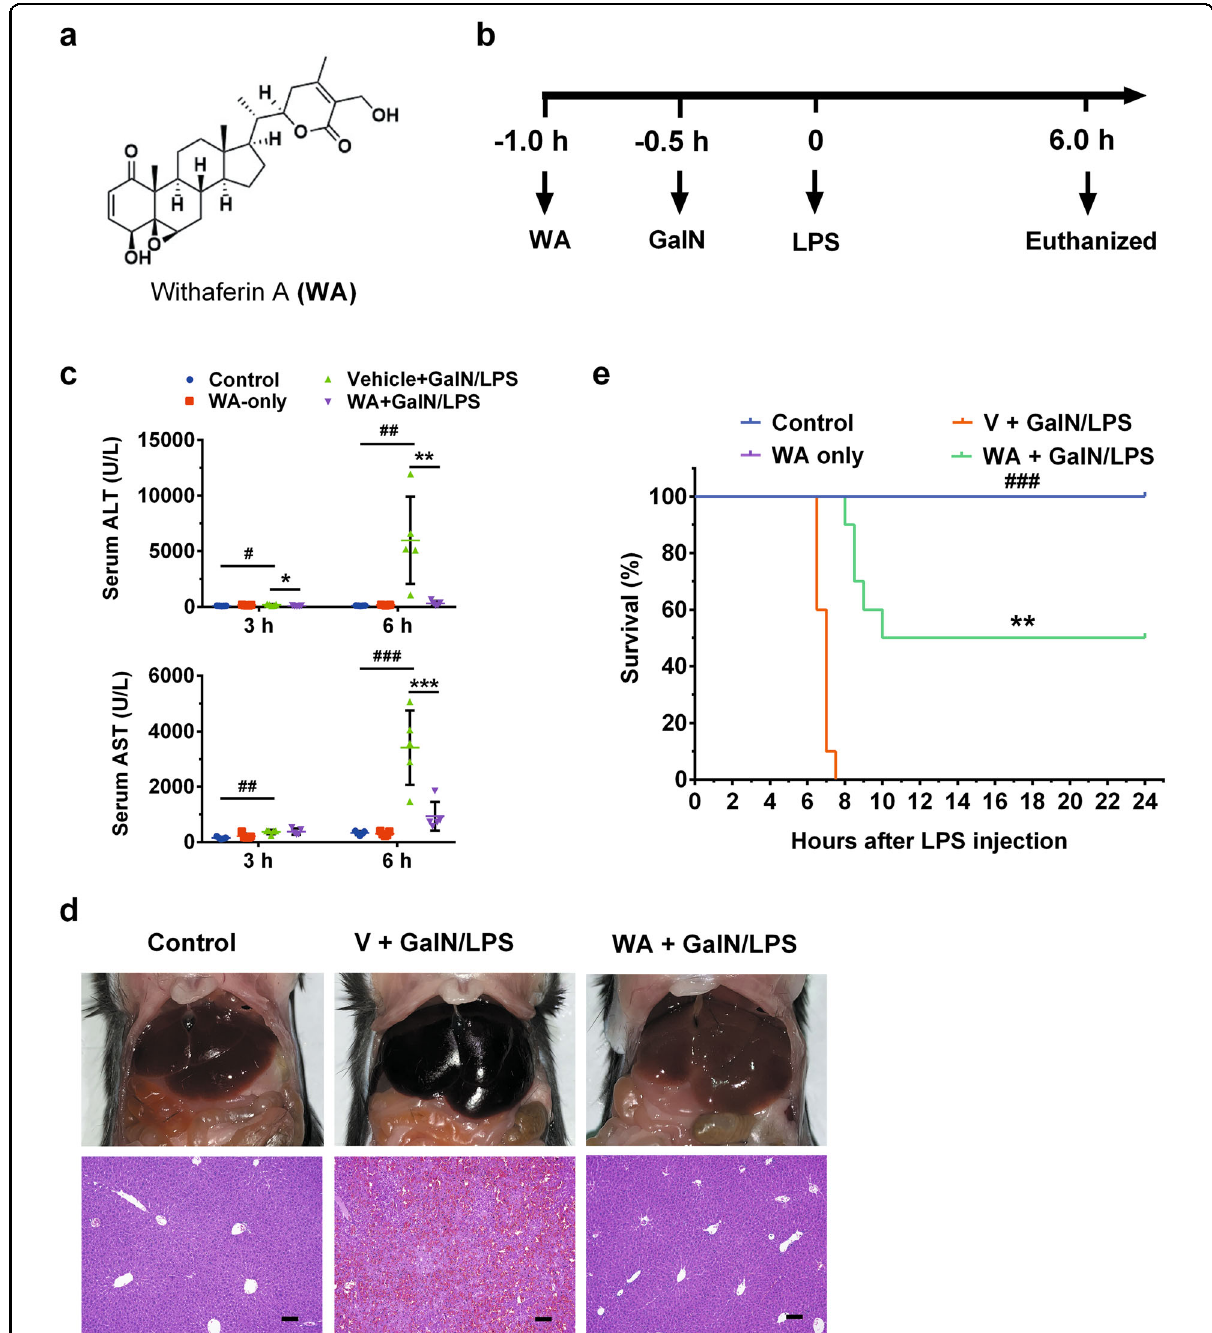
Fig. 1 WA protected against GalN/LPS-induced FH in WT mice. a The chemical structure of WA. b Dosing scheme of animal experiments. c Serum ALT and AST levels at 3 h and 6 h after GalN/LSP treatment. d Representative liver images and liver histological H&E staining, scale bar 50 μ m. e Survival curve ( n = 10). Data are presented as means ± SD ( n = 5 unless otherwise indicated). Control, mice dosed with control vehicle and saline; WA only, mice dosed with WA and saline; V + GalN/LPS, mice dosed with control vehicle (V), and GalN/LPS; WA + GalN/LPS, mice dosed with WA and GalN/LPS. One-way ANOVA was used for statistical analyses. # p < 0.05, ## p < 0.01, and ### p < 0.005 versus Control group; * p < 0.05, ** p < 0.01, and *** p < 0.005 versus V + GalN/LPS